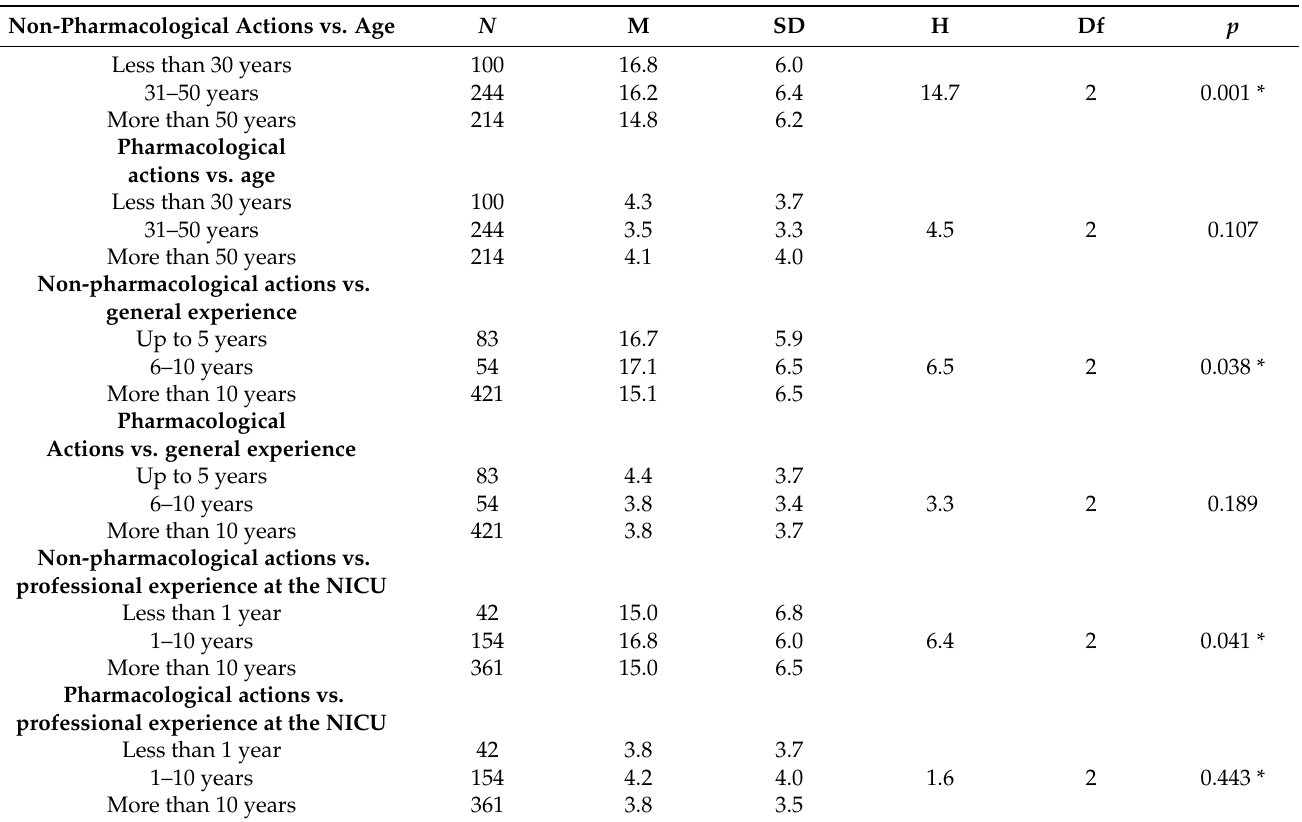
Table 5. Age, general professional experience, and professional experience gained at NICU vs. non- pharmacological and pharmacological